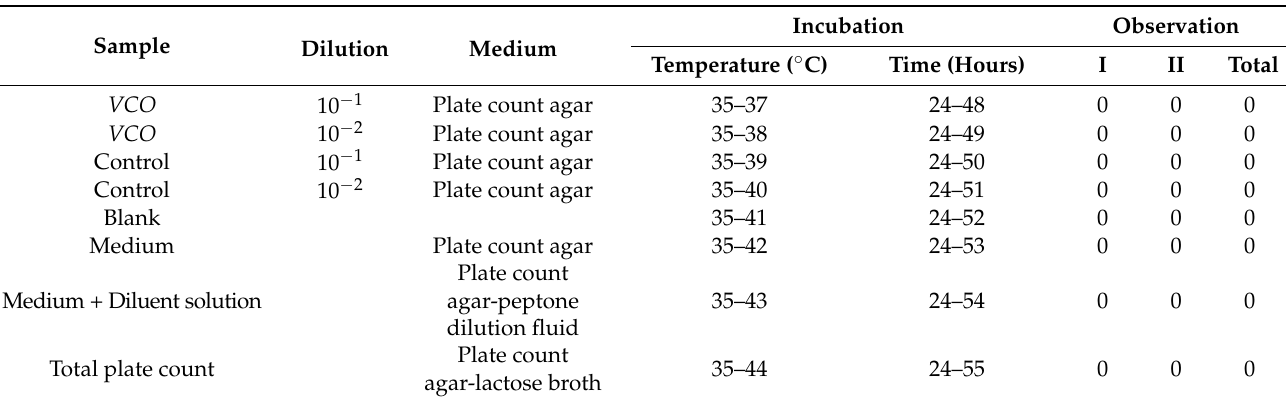
Table 3. Determination of total plate count.